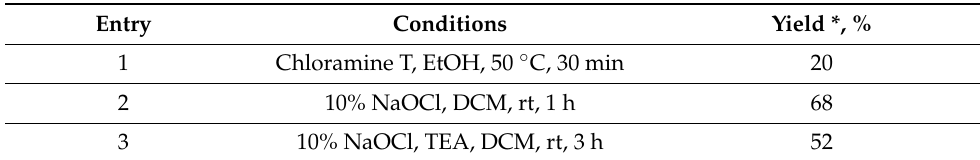
Table 1. Optimization of the INOC reaction conditions for 5a synthesis.